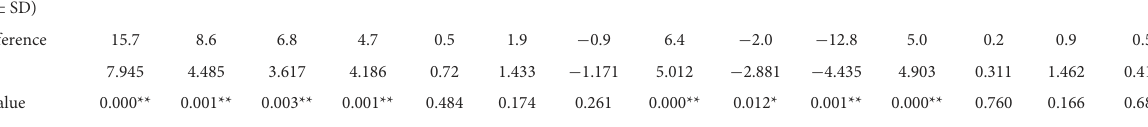
The RSR values of attack, defense, and the overall attacking and defensive performance among the top eight and bottom eight teams were conducted to perform an independent sample